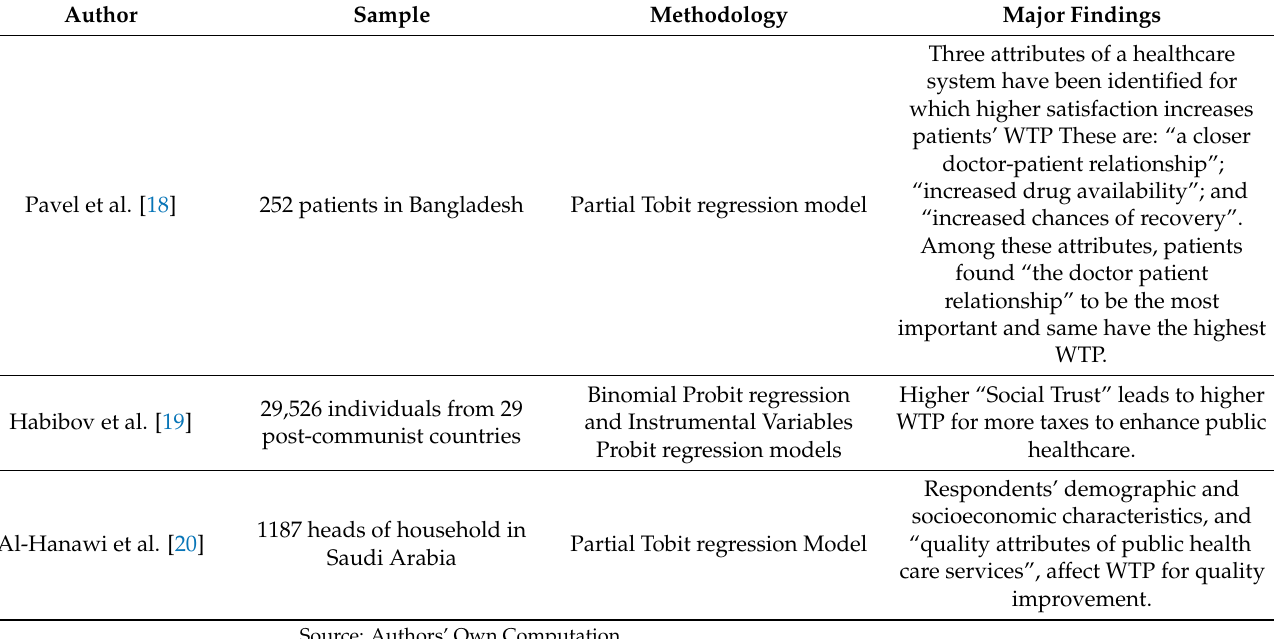
Table 2. Summary Empirical Studies on WTP to improve Quality of Healthcare